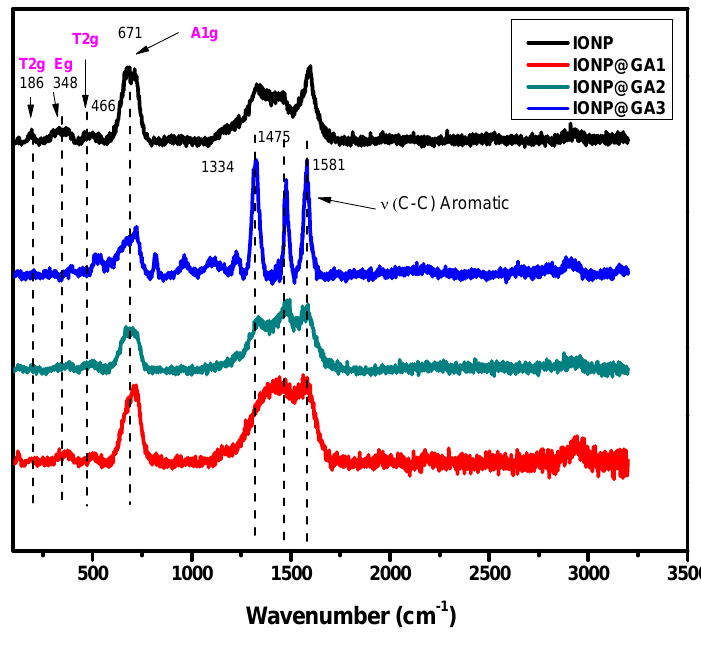
Figure 2. Raman spectra of